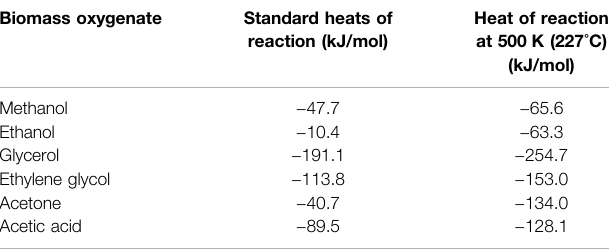
TABLE 2 | Standard heats of reaction (kJ/mol) for H 2 recovery from aqueous biomass oxygenates with inherent carbon removal: C x H y O z (l) + xCaO (s) + (2x − z)H 2 O (l) → xCaCO 3 (s) + (2x − z + 0 . 5y)H 2 (g) . Heat of formations for reacting and product species was obtained from (Williams,